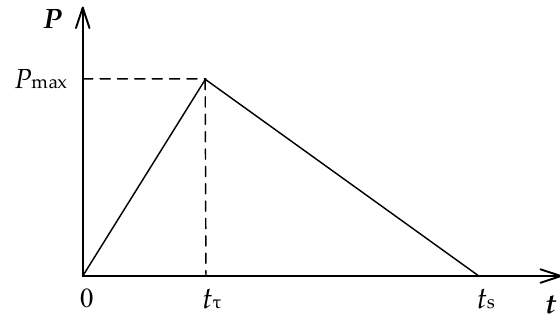
Figure 7. Schematic diagram of triangular blasting